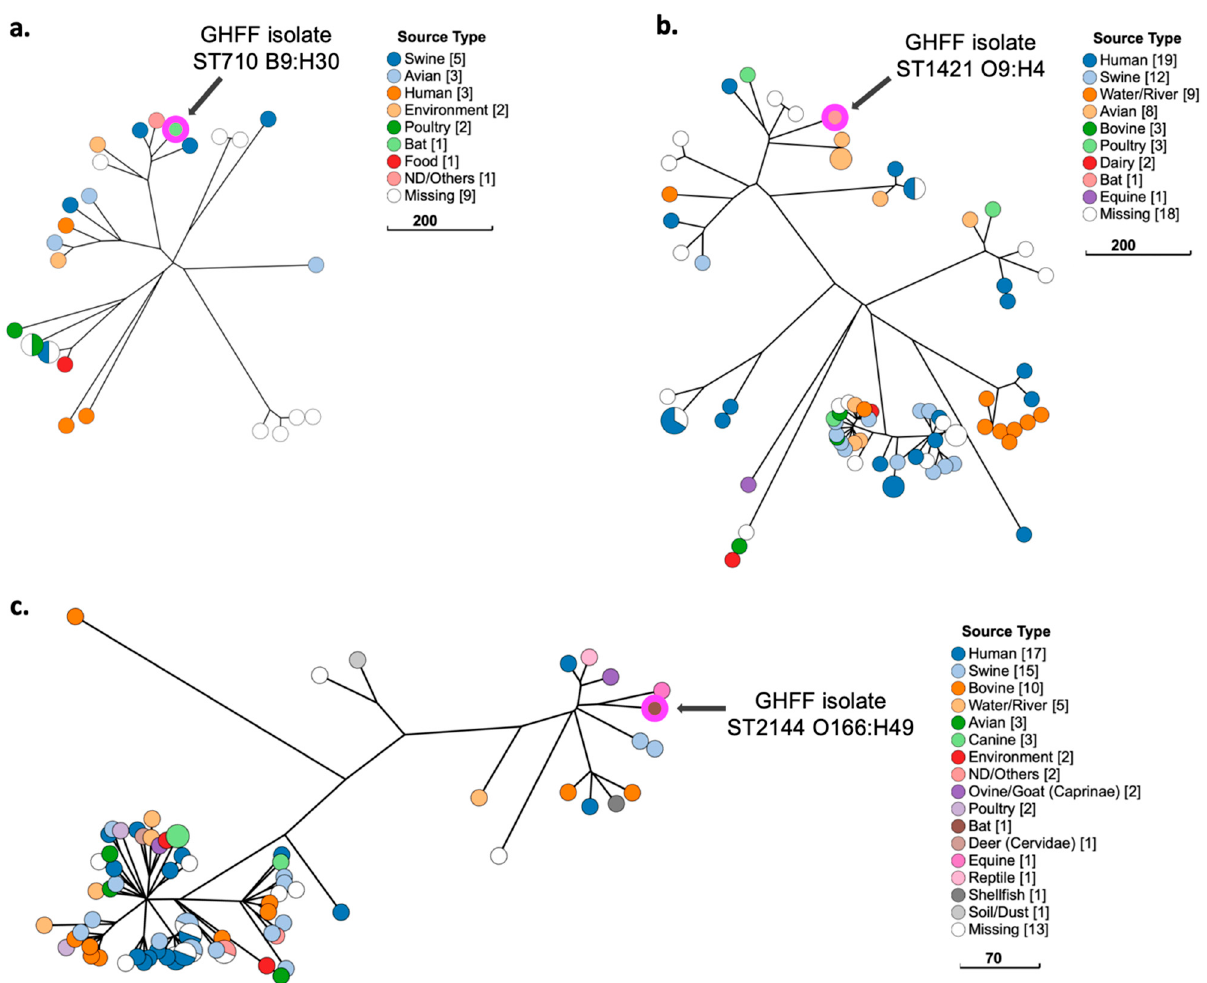
Figure 7. Phylogenetic and metadata analysis of three low-pathogenicity E. coli isolates from grey- headed flying fox (GHFF) pups and closely related isolates from human, animal, and environmental sources identified in EnteroBase. GrapeTree phylogeny constructed using a rapid neighbour joining (RapidNJ) minimum spanning tree based on the cgMLST V1 + hierarchical clustering (HierCC) V1 scheme. Scale bars indicate the number of cgMLST allelic differences. GitHub URL links for interactive versions of all GrapeTrees are provided in Supplementary Table S4. ( a ) ST710 B9:H30; ( b ) ST1421 O9:H4; ( c ) ST2144 O166:H49.